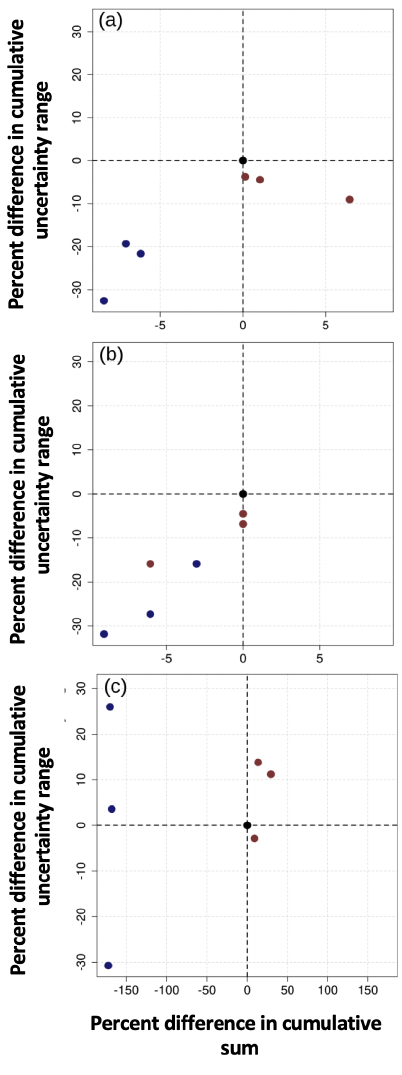
Figure 5. Comparison of percent differences from cumulative sums and associated uncertainty (95% CI) between greenhouse gas fluxes derived from automated measurements ( F A ) and using an optimized sampling approach (tuLHs) or a fixed temporal stratifica- tion. Differences are represented for soil CO 2 (a) , soil CH 4 (b) , and soil N 2 O (c) fluxes. The black circle in the center (0, 0) of a plot represents the values derived from automated measurements ( F A ). Blue circles represent estimates from fixed temporal stratification, and red circles represent estimates from an optimized sampling ap- proach (tuLHs). Estimates were calculated based on the 258 avail- able automated measurements (Fig. 2), and numeric estimates are in Table S3. Note the difference in the scale of the x axis among